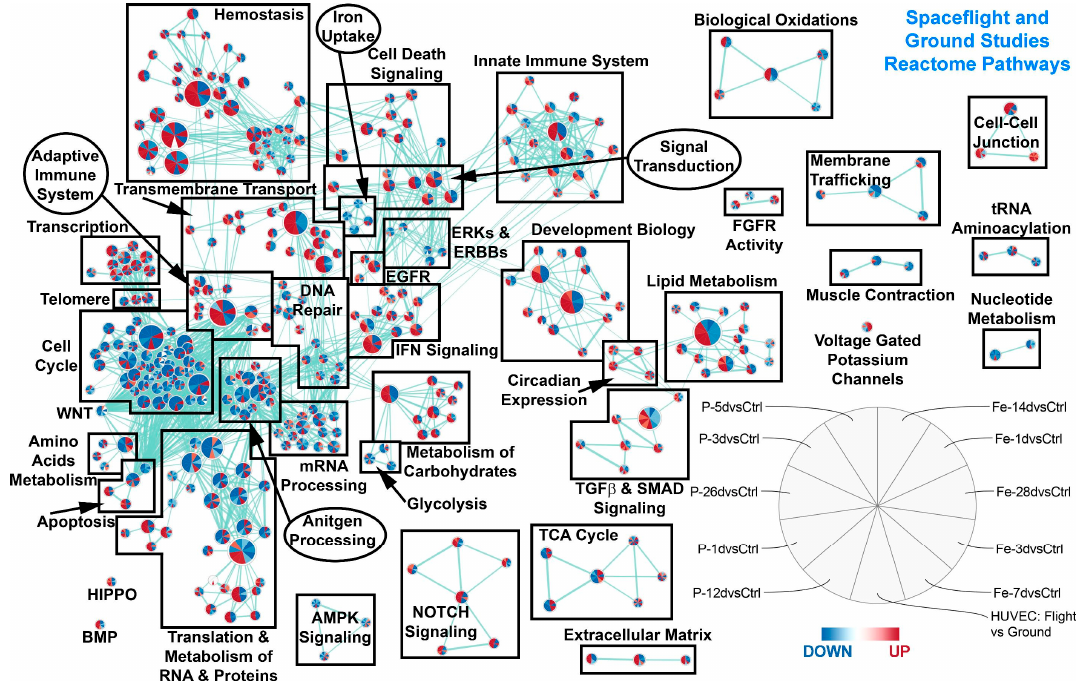
Figure 3. Gene set enrichment analysis (GSEA) with the Reactome gene sets comparing different time-points after irradiation with either protons or 56 Fe with the HUVECs flown in the space. All samples were comparing experimental conditions with the respective controls. The significant gene sets were determined with FDR ≤ 0.05. Each node represents one gene set and the size of the node indicates the number of genes involved with the predictions. Each node contains 11 wedges for each condition and the color of each wedge indicates if the gene set is downregulated (blue) or upregulated (red). The shade of the color indicates degree of regulation.